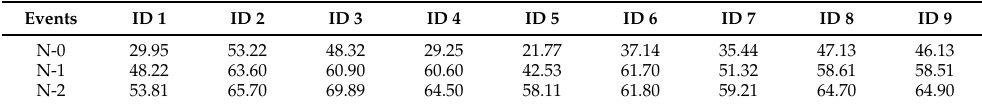
Table 9. Maximum partial demand at each charging station with 9984 km of road network given a contingency.